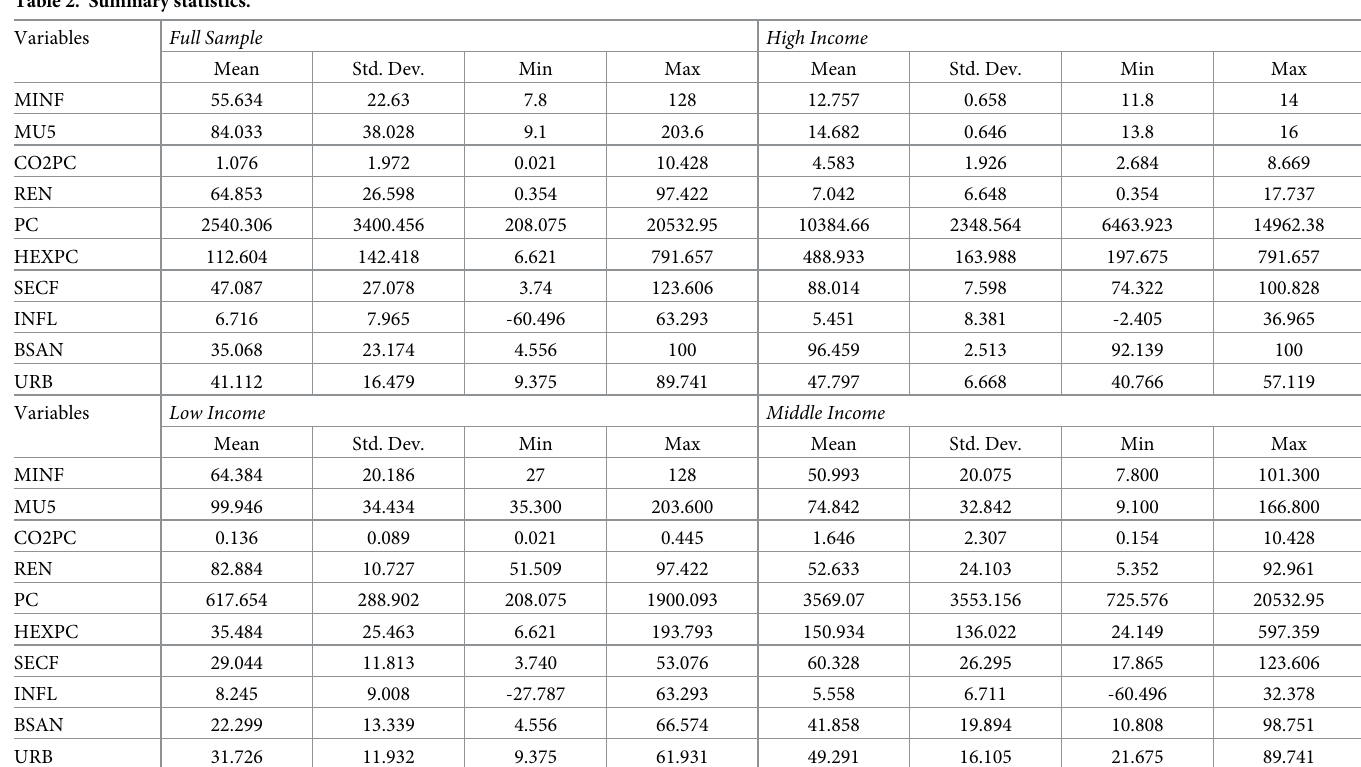
Table 2. Summary statistics.